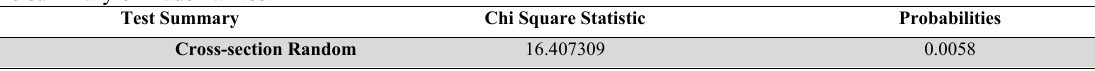
The summary of Hausman